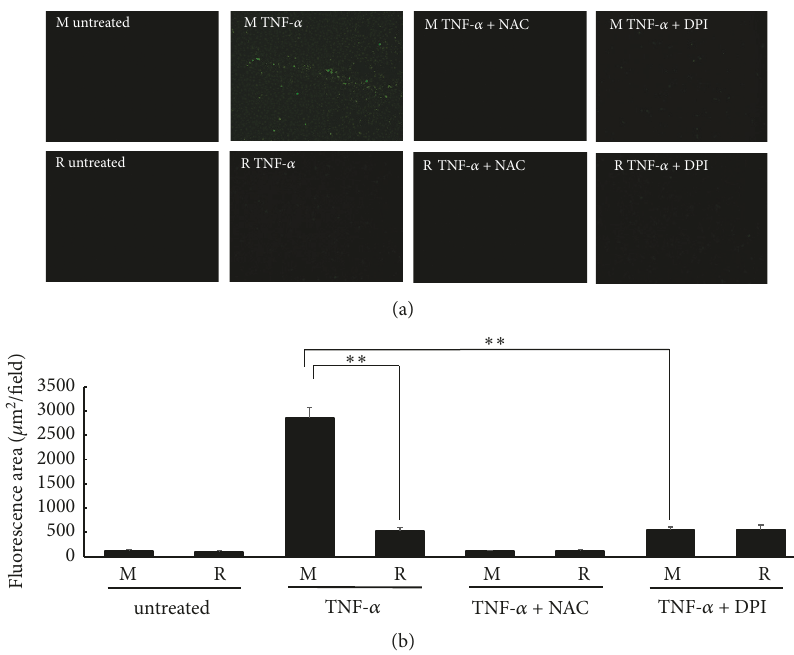
Figure 4: Apoptosis by TNF- 𝛼 stimulation. Each cell line was treated with 20ng/mL TNF- 𝛼 for 24h and stained using NucView 488. (a) Cells were photographed with fluorescence microscopy (40 × magnification). (b) A fluorescent image was taken and digitized using ImageJ. M: mock cells, R: TERT HUVEC R cells. n=3; ∗∗ p <